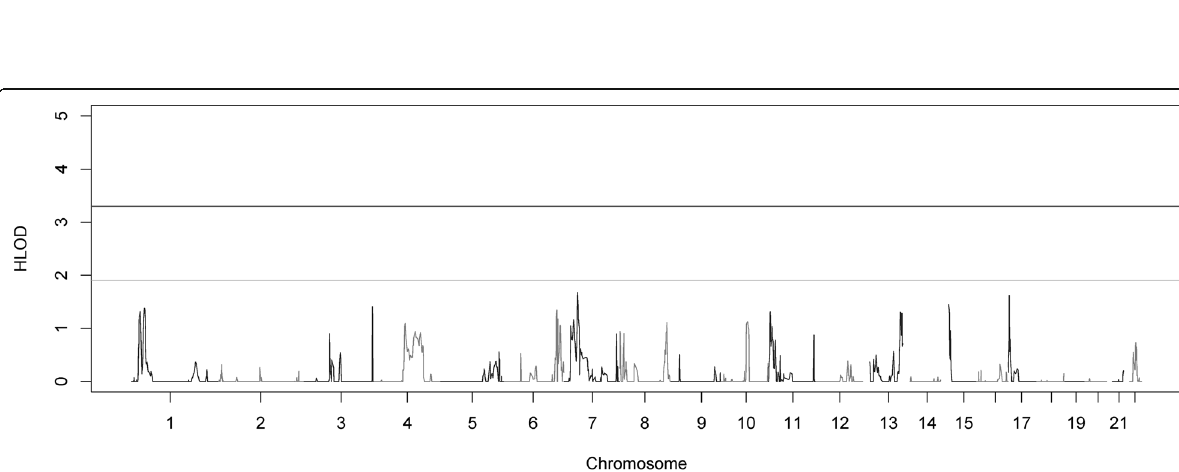
Fig. 3 Genome-wide plot of multipoint heterogeneity LOD (HLOD) scores across the 64 Ashkenazi families. The lines at 1.9 and 3.3 represent the respective suggestive and significant thresholds recommended by Lander and